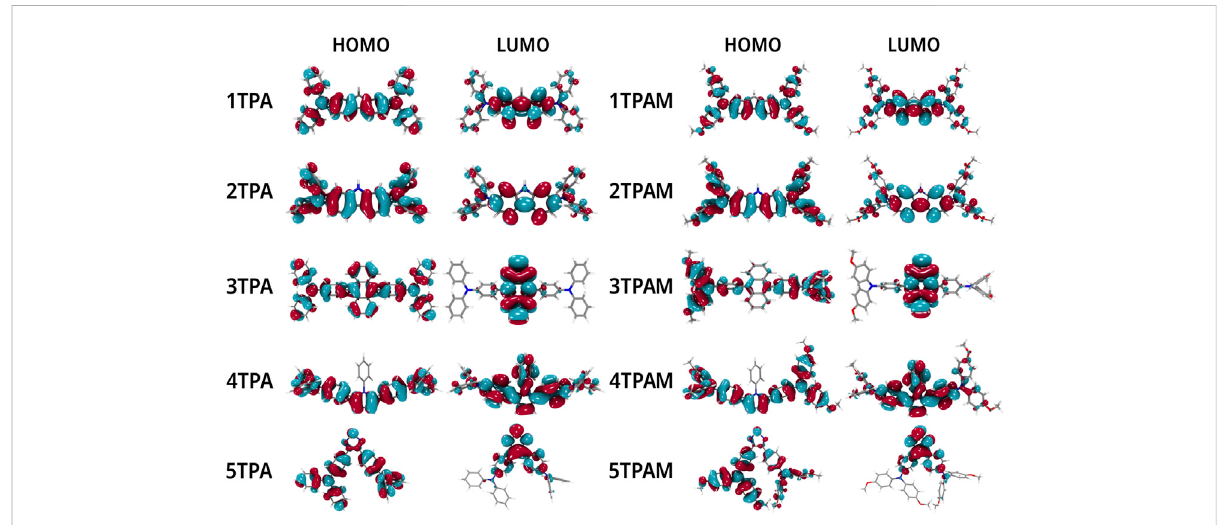
FIGURE 6 Localization of the frontier molecular orbitals calculated with M06/6-311++G(d,p) in TPA and TPAM derivatives.